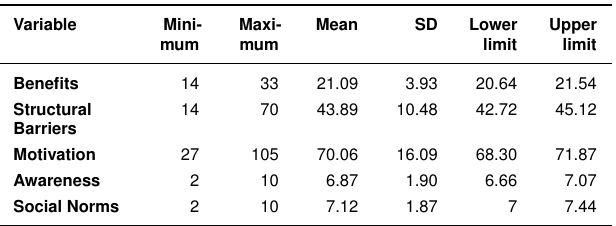
Table 3. Status of the study subjects in terms of indepen- dent variables.